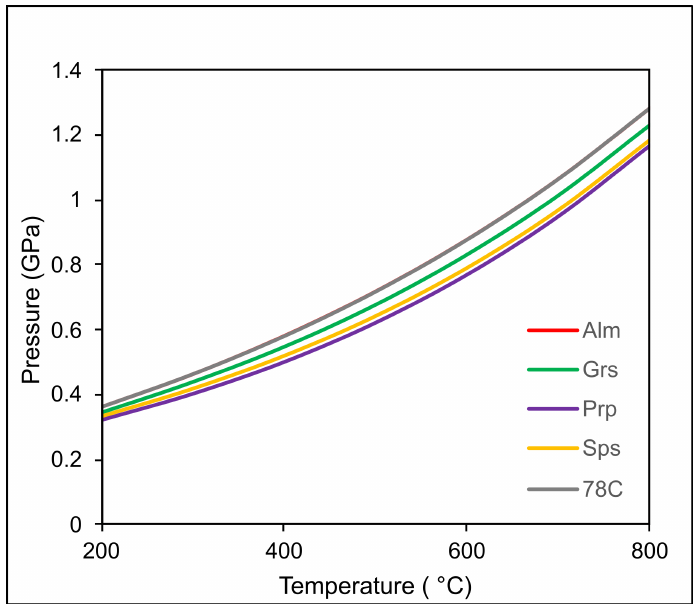
Figure 3. QuiG entrapment isomekes for the inclusion G3-15 (P inc = 0.126 GPa) calculated using various equations of state [10,13,14]. Note that almandine overlaps with the EoS for garnet 78 ◦ C. Table 4. Raman and strain data. Incl. is the inclusion number, 207 is the measured position of the 207 band, 464 is the position of the 464 band, d is the difference between the measured and standard positions, e are strains calculated in Strainman [24], P 207 is the inclusion pressure calculated using the hydrostatic shift of 207 [30]. P 464 is the inclusion pressure calculated using the hydrostatic shift of 464 [30], P stress is the inclusion pressure calculated using the strains [44]. The uncertainties of P 464 and P stress are 0.05 Gpa [30] and 0.3 GPa, respectively.